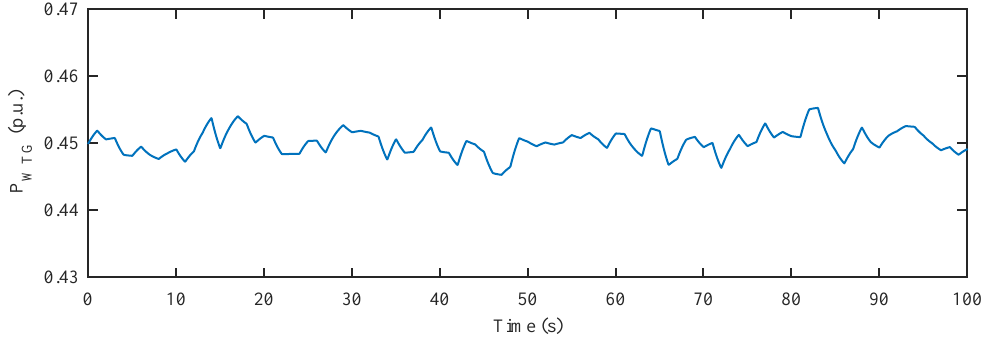
Figure 17. The total stochastic power output of the WTG.